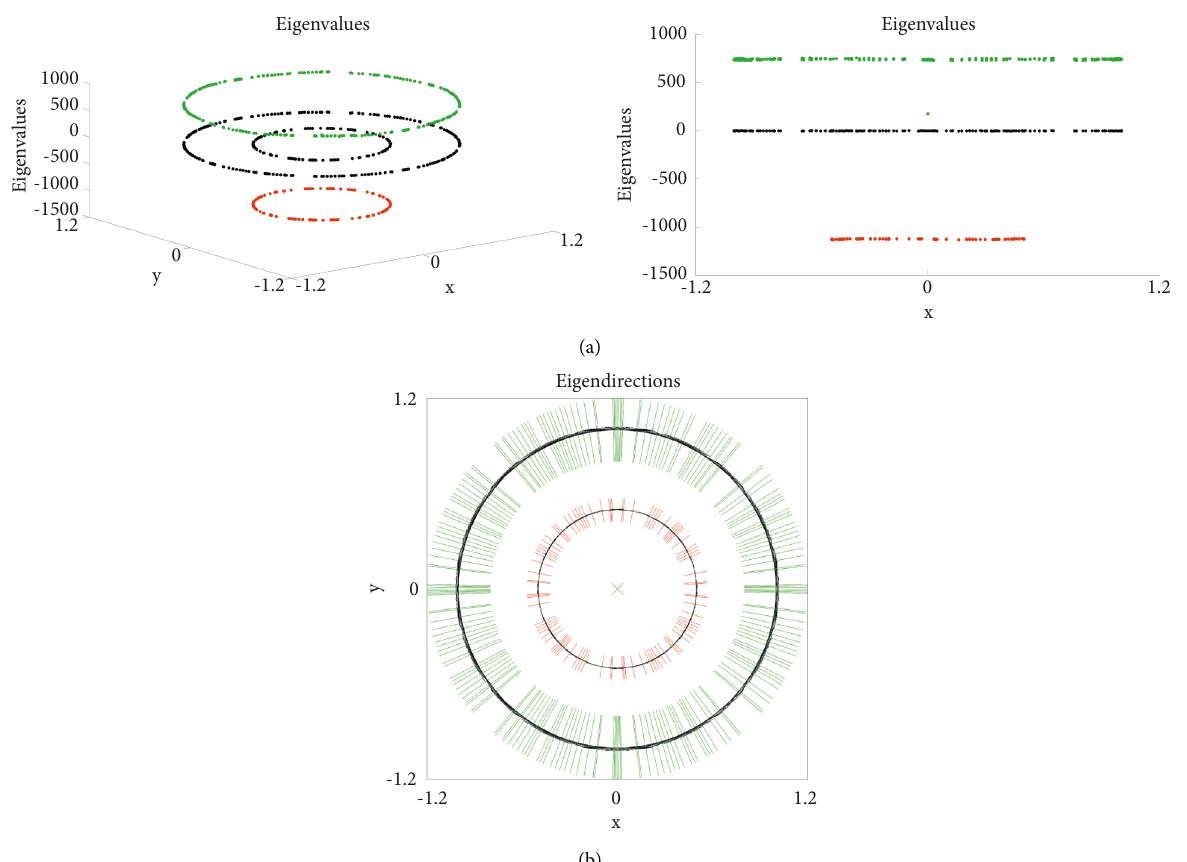
Figure 6: System (19). (a) Eigenvalues of the Hessian at points of the underestimation C v, 0 . 8 of the chain recurrent set: green (positive, attractive), black (zero, neutral), and red (negative, repelling). (b) Corresponding eigendirections, indicating attractive, repelling, and neutral directions to the connected components of the chain recurrent set. The outer periodic orbit has a 1-dimensional neutral direction and a 1-dimensional attractive one, and the inner periodic orbit has a 1-dimensional neutral direction and a 1-dimensional unstable one, while the equilibrium has a 2-dimensional stable manifold.